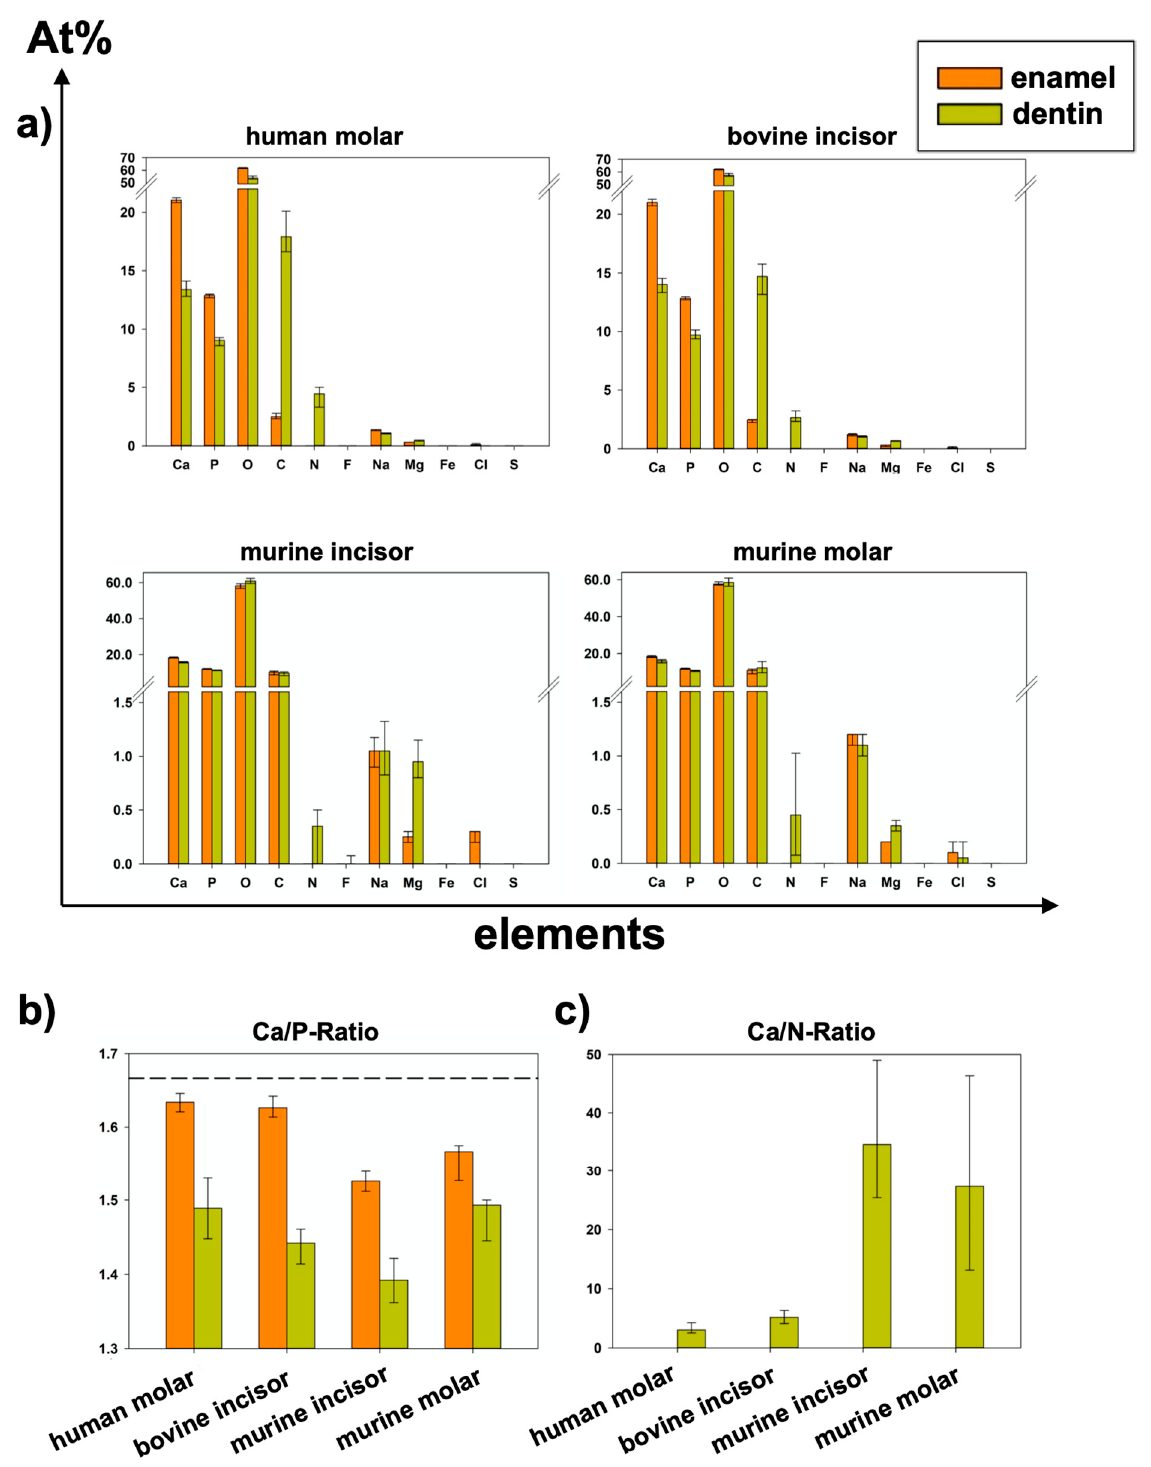
Figure 5. (Data also shown in Table 1; p -values in Tables 2 and 4): ( a ) Elemental composition of summarized areas for each group of teeth separated by enamel or dentin (median and 25–75% percentiles). ( b ) Ca/P-Ratio of all specimens (median and 25–75% percentiles); dashed line shows stoichiometric ratio (1.667) of hydroxy apatite. ( c ) Ca/N-Ratio of all specimens (Median and 25–75% percentiles); Because At%N > 0 was only detected in dentin areas, Ca/N-Ratio could not be calculated for enamel.